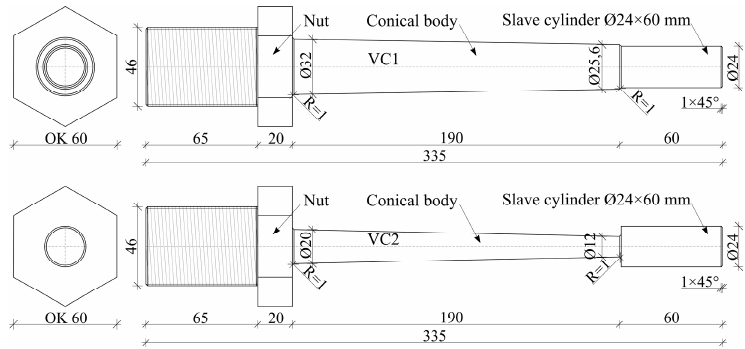
Figure 6. The geometry of the tested vertical components of the energy dissipation device.